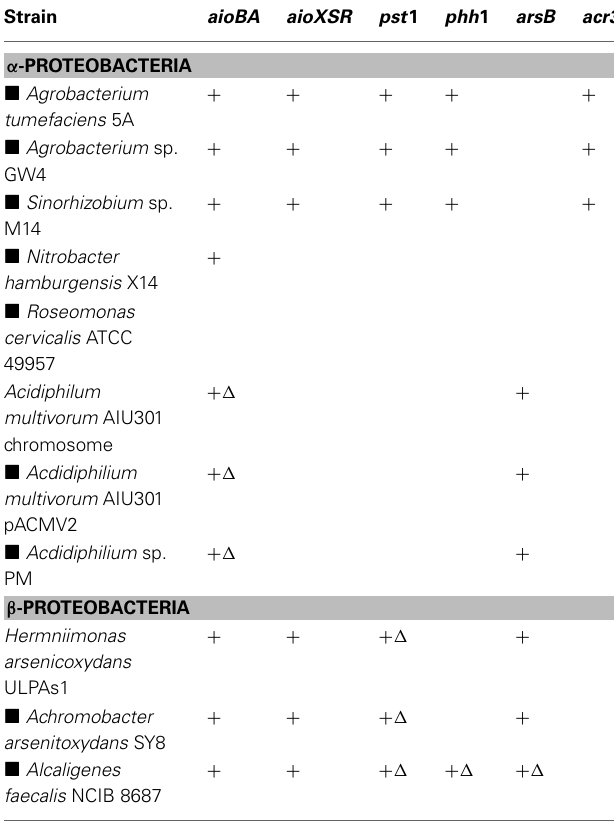
Table 1 | Prediction of putative horizontal gene transfer events in the arsenic